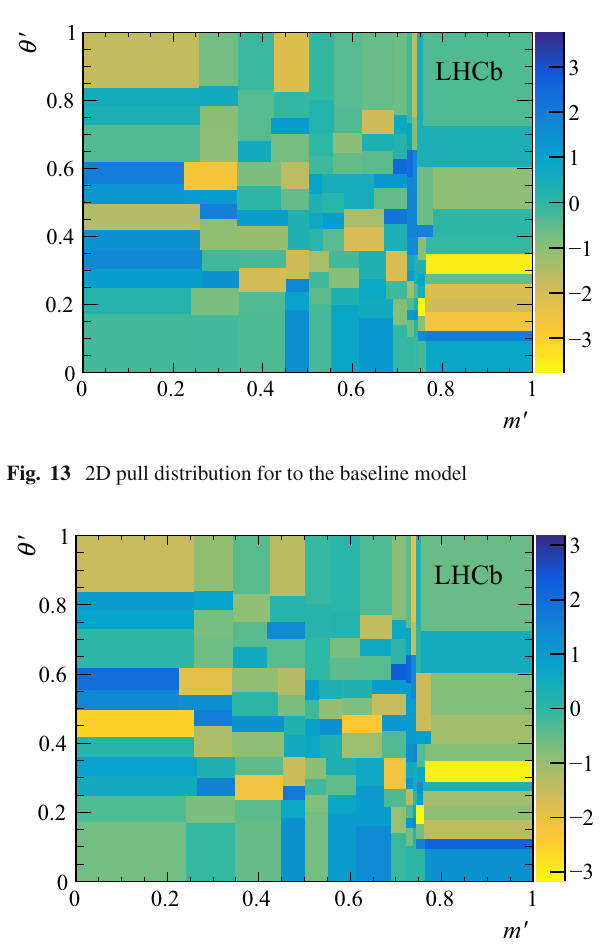
Fig. 14 2D pull distribution for to the nominal